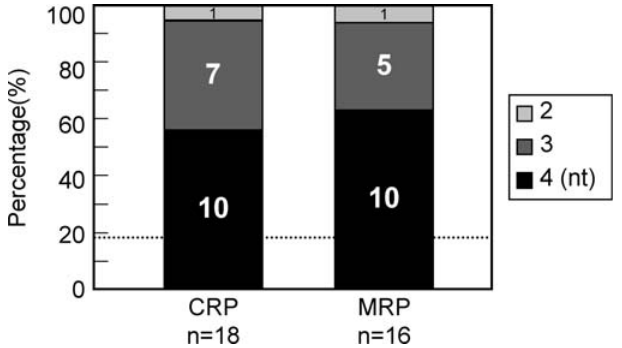
Figure 3. Proto-Splice Site Tendency The percentage of nucleotides that were identical to the proto-splice site sequence was calculated using 18 CRP splice sites and 16 MRP splice sites in nine shared intron positions. For example, ten (63%) of the splice sites in MRP genes have four-nucleotide (nt) matches with the proto- splice site (MAG j R). The dotted line shows the estimated average in the whole genomes of seven species. DOI: 10.1371/journal.pgen.0020025.g003